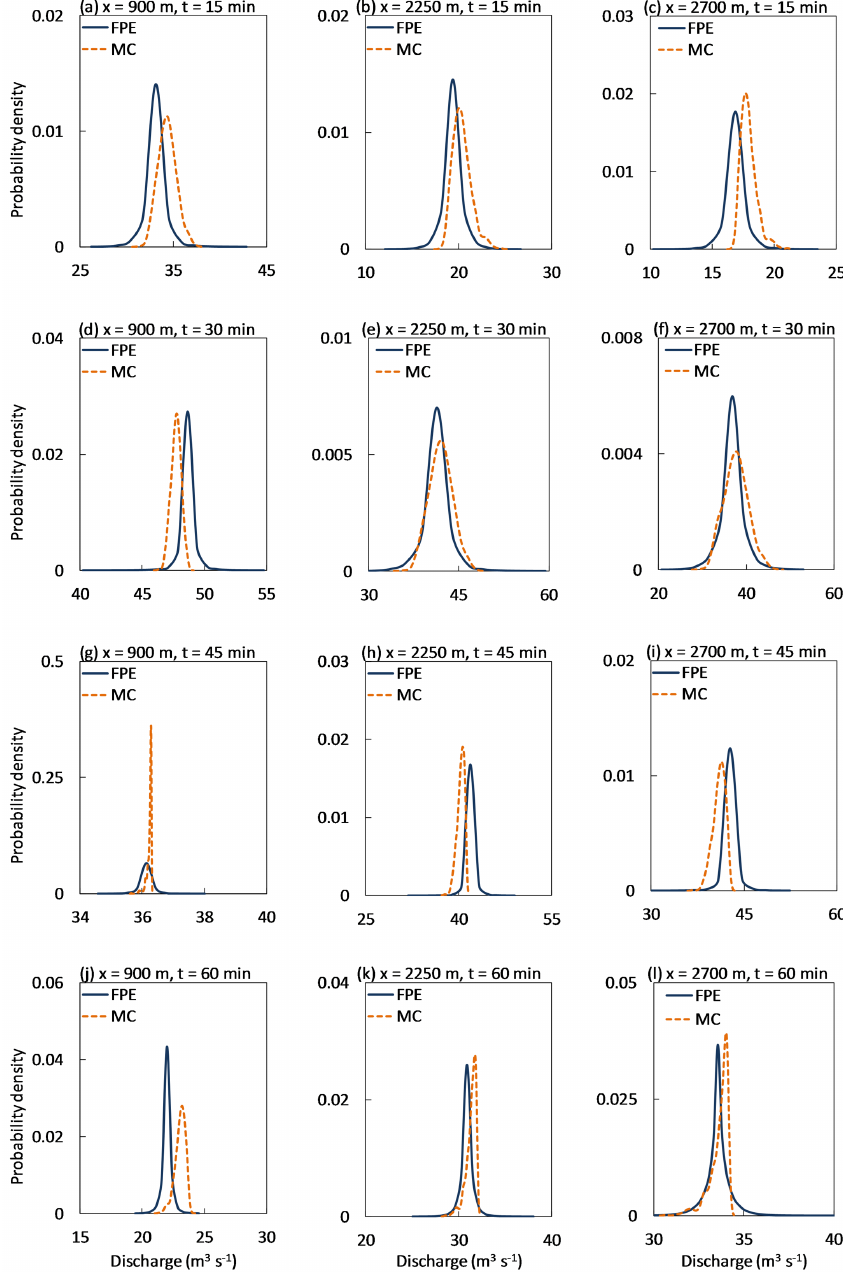
Figure 11. Comparison of the probability density functions of the flow discharge obtained by the FPE methodology and the MC approach, plotted at different times and channel